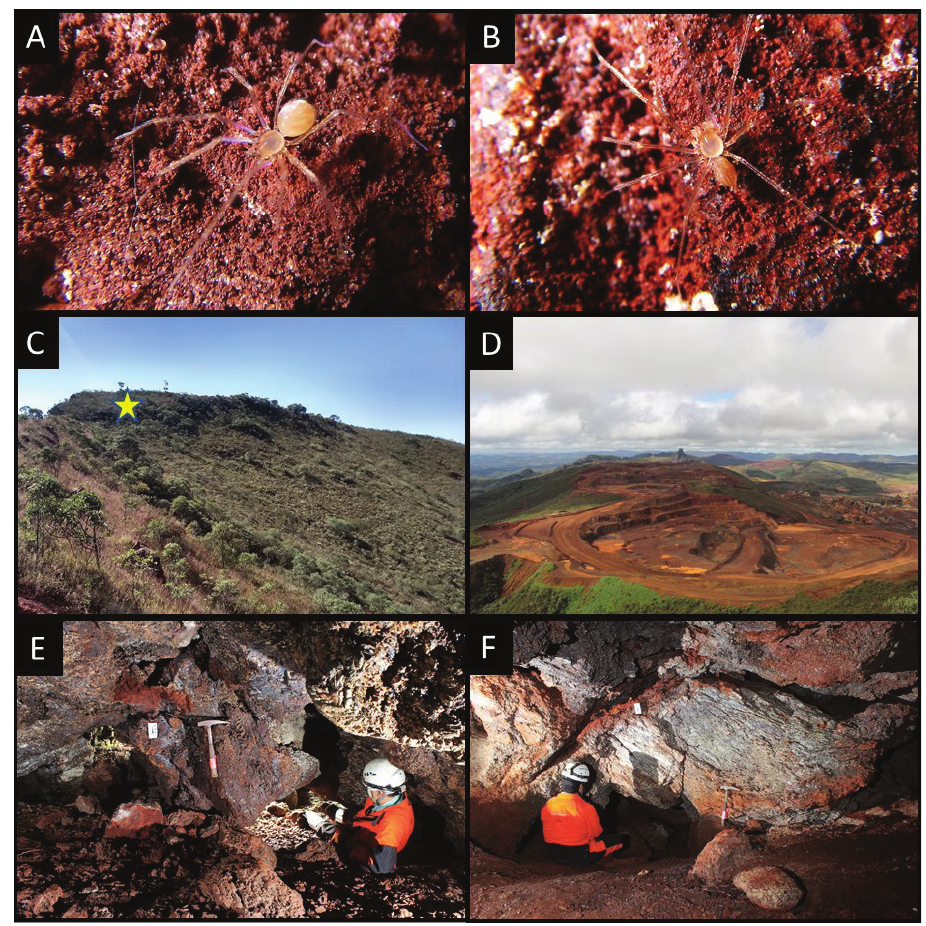
Figure 15. Ochyrocera dorinha sp. nov. A female B male C Landscape where cave MP_0008 is located (type locality). The yellow star represents the exact location where the cave is inserted D Mining located around cave MP_0008 E Entrance to cave MP_0008 F Internal aspect of cave MP_0008 (iron